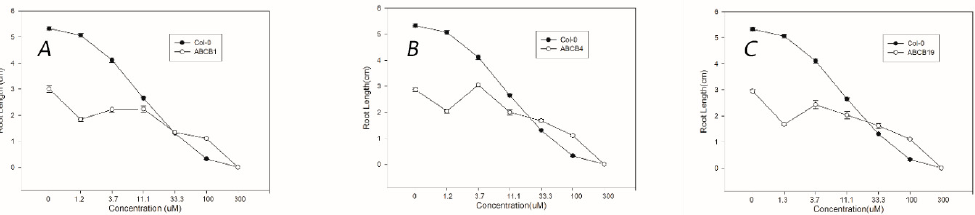
Figure 8. Root length of 3 biotypes at 7 days after treatment with 0 μ M, 1.3 μ M, 3.7 μ M, 11.1 μ M, 33.3 μ M, 100 μ M and 300 μ M quinclorac. ( A – C ) represent the comparison of root length between AtABCB1 , AtABCB4 , AtABCB19 and the parent line. Data are the mean values of at least 10 biological replicates. The standard errors of the means are described by vertical bars. Table 4. The IC 50 were measured after treatment with quinclorac in the parent line and mutants.